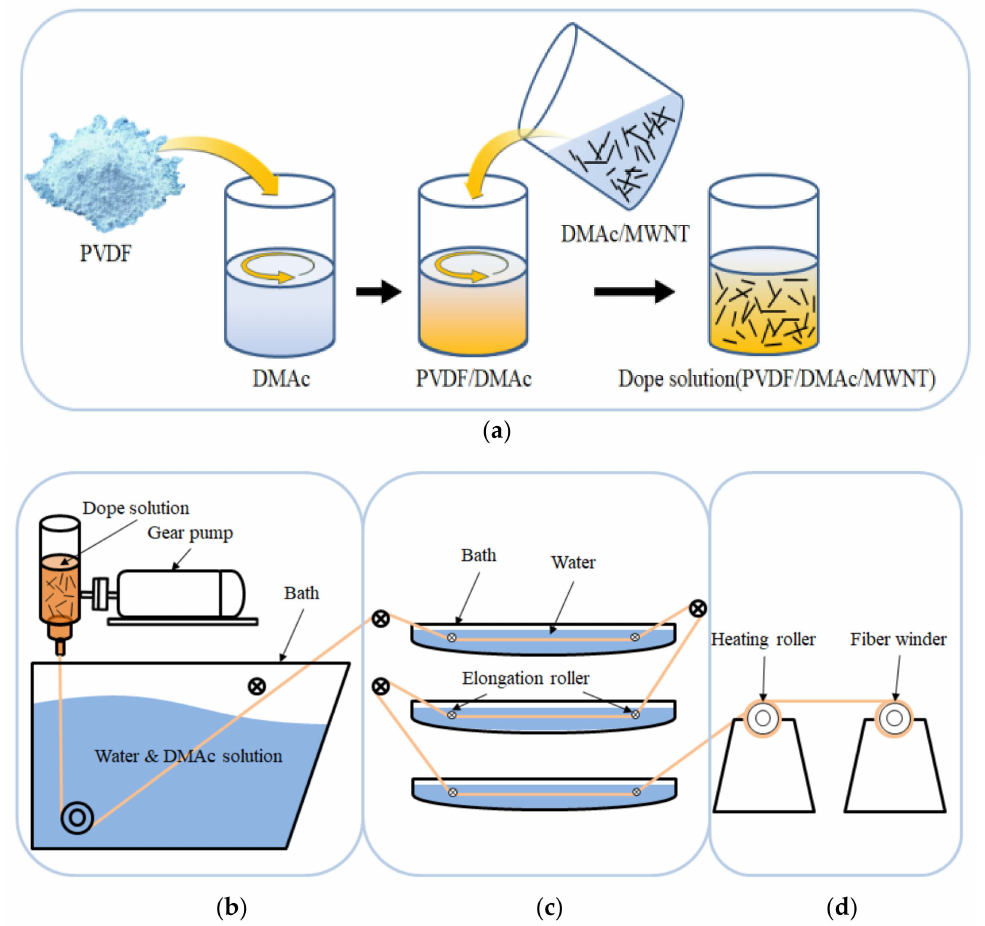
Figure 1. Wet-spinning process for the production of CNT/PVDF fibers. ( a ) Dope solution; ( b ) Coagulation bath; ( c ) Washing and drawing baths; ( d ) Dryer and